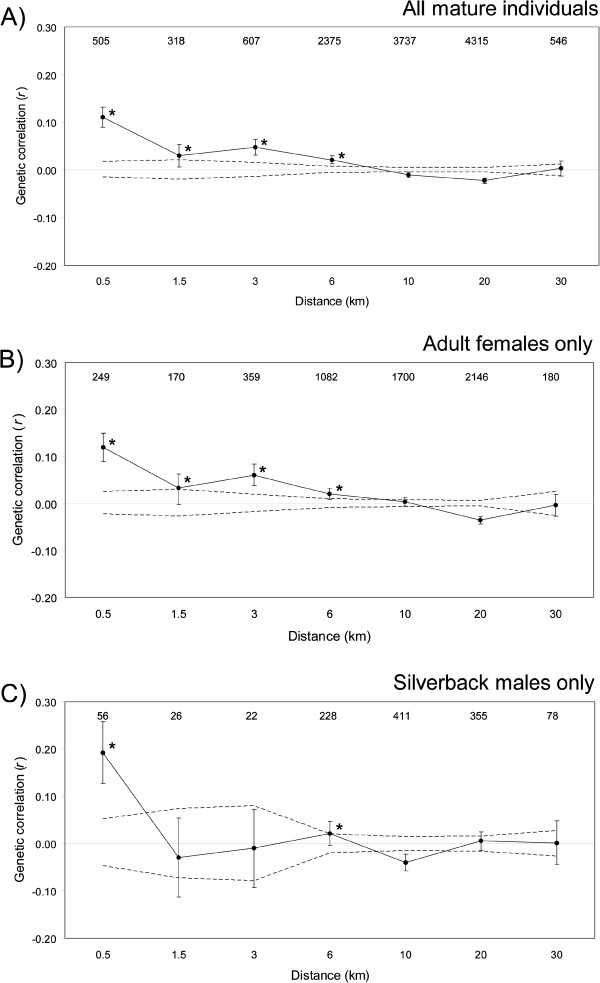
Correlogram plots of the genetic correlation coefficient (r) as a function of geographic distance between individuals. The 95% confidence interval about the null hypothesis of a random distribution of genotypes (dashed lines) and the bootstrapped 95% confidence error bars are also shown. The number of pairwise comparisons within each distance class is presented above the plotted values. (A) All mature individuals (n = 158); (B) Adult females only (n = 109); (C) Silverback males only (n = 49). All individuals of the same group fall within the 0.5 km distance class. Asterisks denote significantly positive r values at α = 0.05.